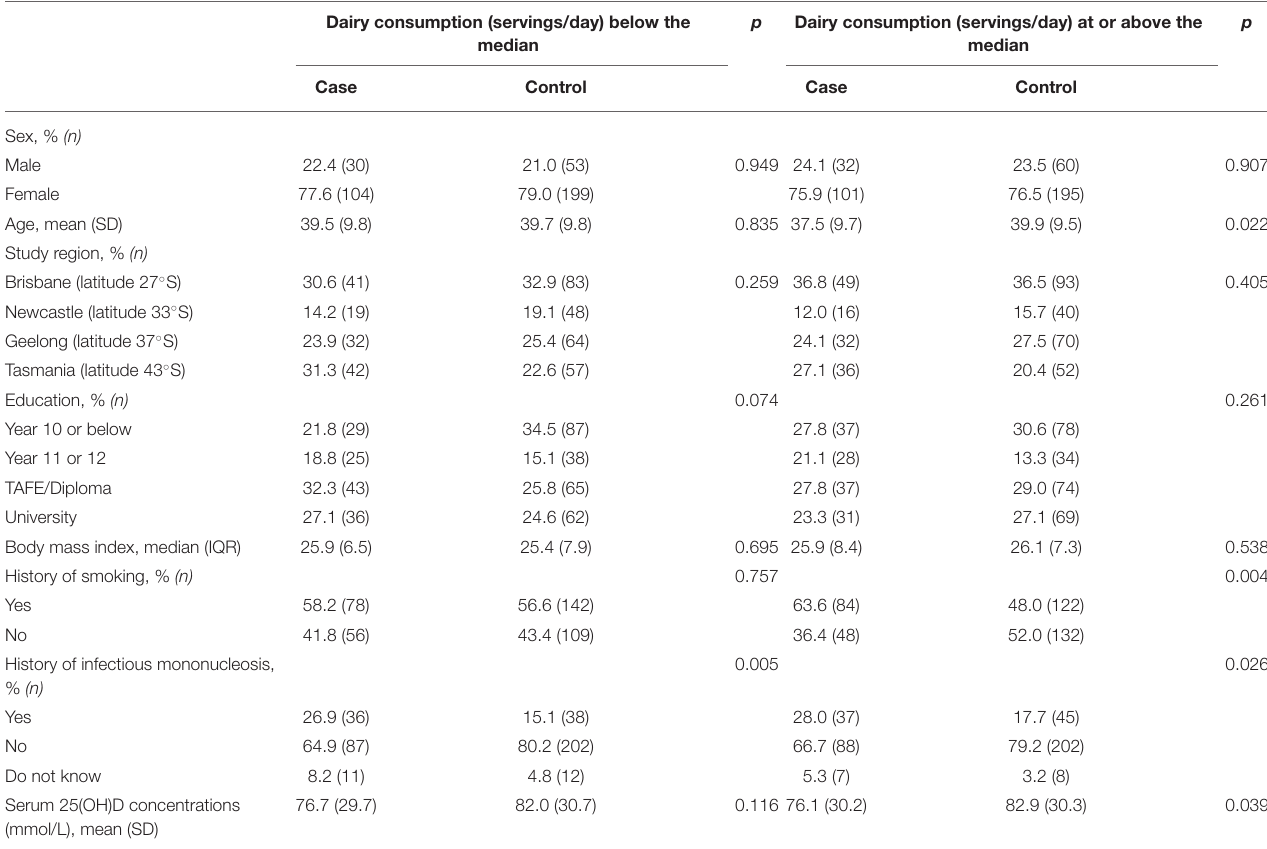
TABLE 1 | Characteristics of participants included in the current study ( n = 774; 267 cases, 507 controls) by dairy consumption (servings/day) below the median compared with at or above the median. p Dairy consumption (servings/day) at or above the Dairy consumption (servings/day) below the median median